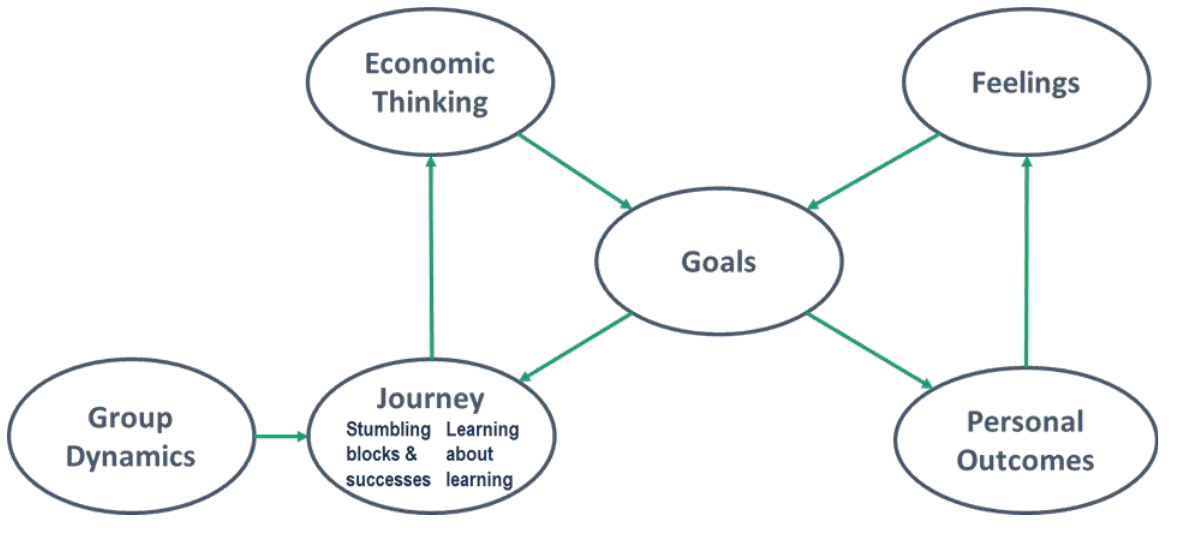
Figure 1 : Systems Influence Diagram: Students’learning in the TC programme The structure of the SID offers a way of understanding how the students viewed the dynamics of their learning. Each oval represents an affinity, and the arrows indicate directions of influence. Group Dynamics was the primary driver of the system, impacting on every other affinity. The Learning Journey and Economic Thinking were influential secondary drivers, while Goals, Personal Outcomes, and Feelings were outcomes in the overall system. Two interconnected sub-systems can be discerned: Journey – Economic Thinking – Goals, and Goals – Personal Outcomes – Feelings. We use this structure together with the affinity descriptions above to expand on students’ theori sing of these elements of learning and relate this understanding to extant